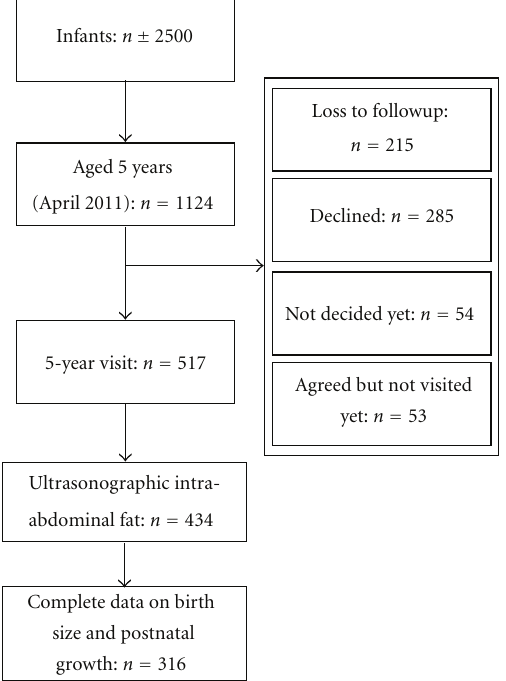
Figure 1: Overview of the study